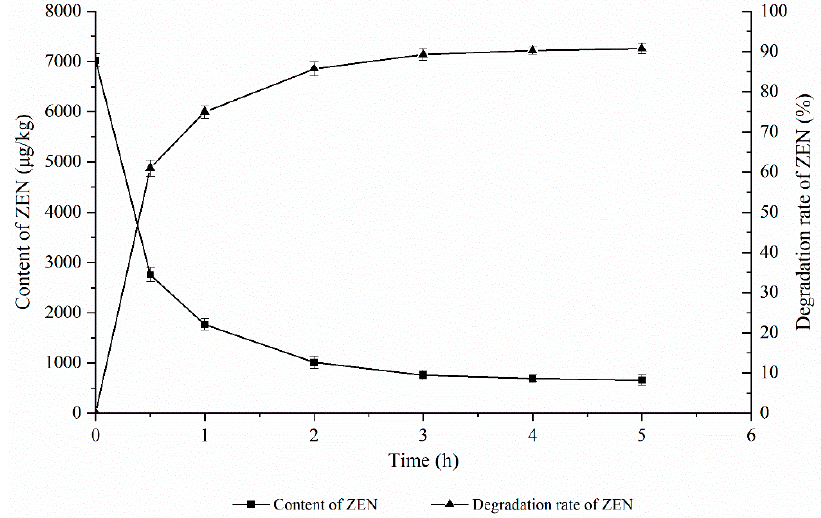
Figure 3. Effects of reaction time on the degradation of zearalenone.